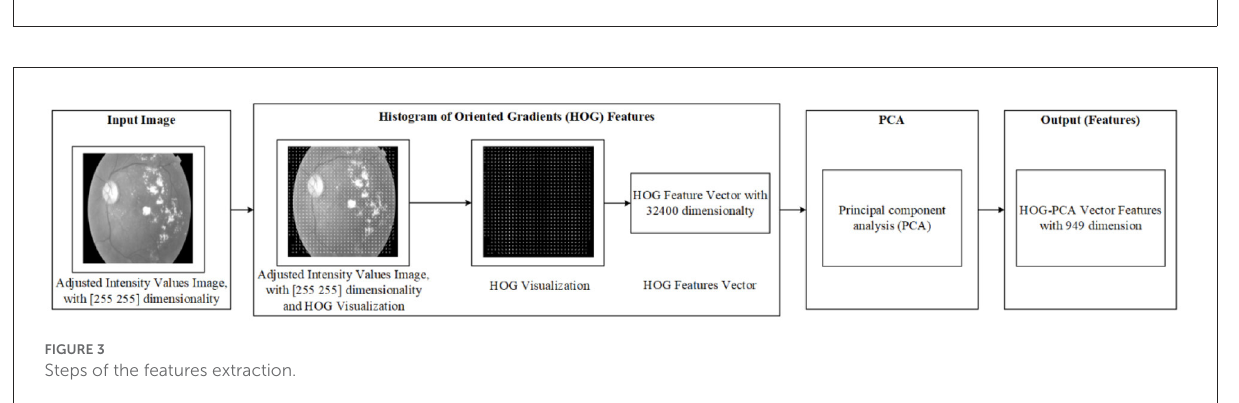
FIGURE3 Steps of the features